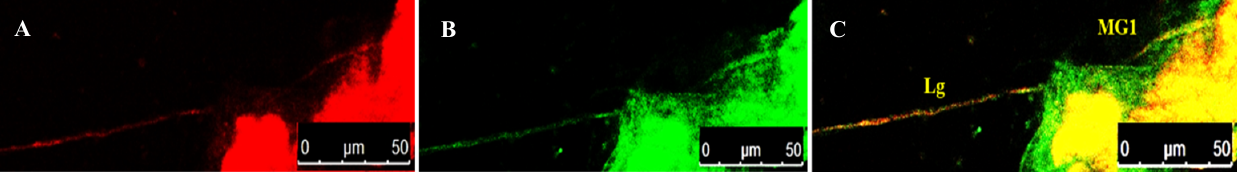
Figure 6. Accumulation of WBNV in ligaments connecting PSG to anterior midgut during P2 stage of Thrips palmi . ( A ). Alexa Fluor 594 phalloidin-conjugated F-actin probe red fluorescence ( B ). FITC-conjugated goat anti-rabbit secondary antibody green fluorescence indicating WBNV-N protein ( C ). Merged image of red and green fluorescence signals. MG1—midgut 1; Lg—ligament. Ligaments connecting midgut to PSG were intact during pupal stages. WBNV infection was detected in ligaments connecting MG1 to PSG.